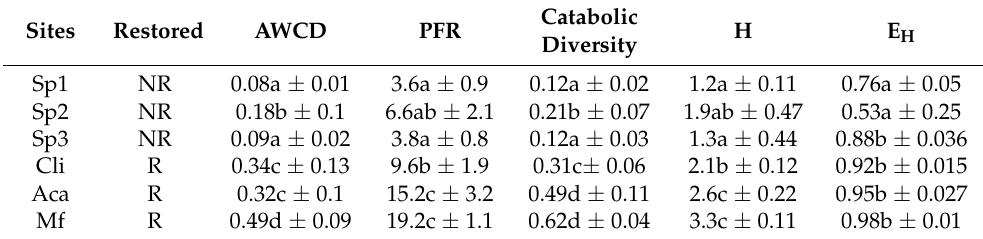
Table 3. AWCD: average well color development, PFR: potential functional richness, catabolic diversity, H: Shannon Index, EH: regularity index, NR: non-restored sites, R: restored sites. Sp1, Sp2 and Sp3 are non-restored mining sites. Cli is a restored site with C. racemosa , Aca is a restored site with A. mangium , and Mf is a mixed fabaceous species ( n = 5, mean ± SD). For each parameter, values followed by different letters differ significantly with p < 0.05 with Tukey’s HSD test.